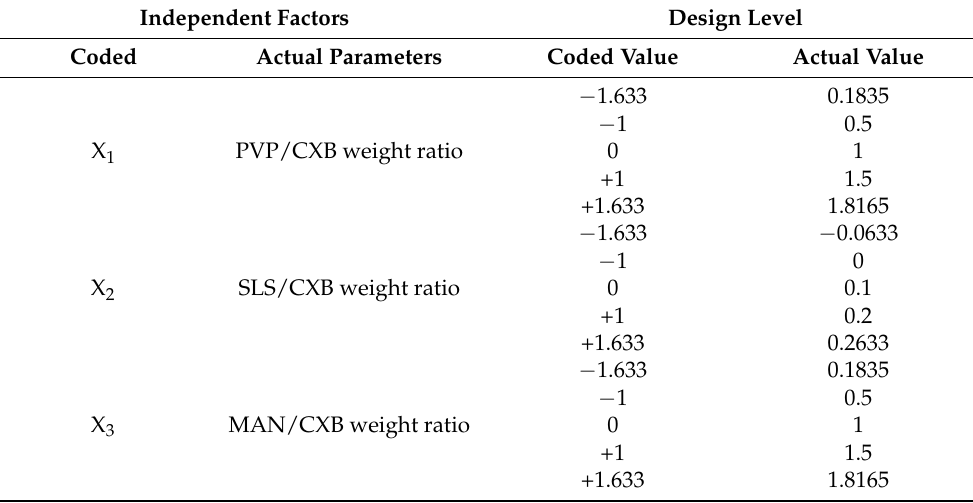
Table 1. The factors and their levels used in CCD.